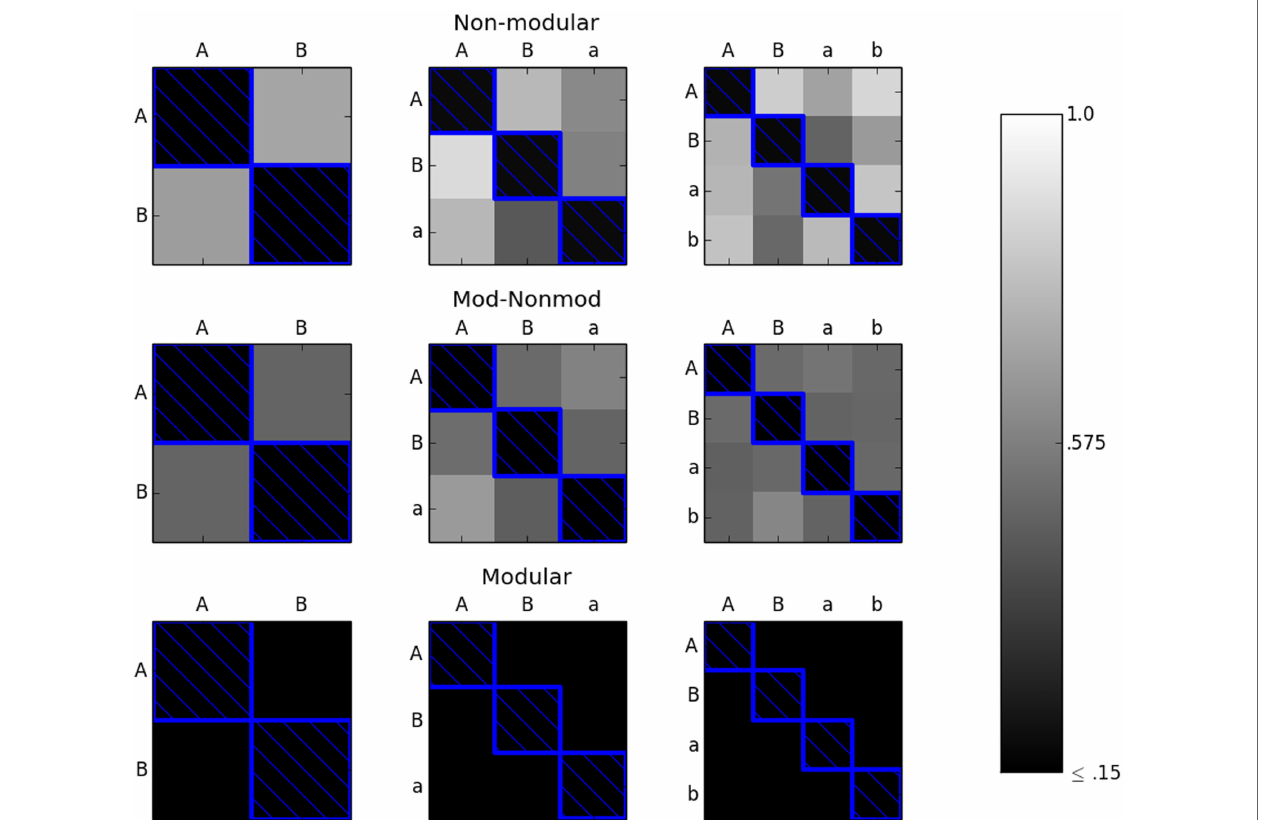
FIGURE 6 | The M (bottom row), MNM (middle row), and NM (top row) robots were evolved along the diagonal (environments with blue boxes around them) until they achieved an error of less than or equal to 0.15 in each environment in the subset considered . The robots were then tested in the remaining environments. The color of the box of each environment represents the average reported error in that environment. The lighter the color, the greater the average error with white representing an error of 1.0 and black representing an error of (cid:20) 0.15. In the modular case, every robot achieved an error of less than or equal to 0.15 on the off-diagonal environments. Over the 50 trials, both the non-modular and mod-non-modular robots averaged an error greater than 0.15 in all of the off-diagonal